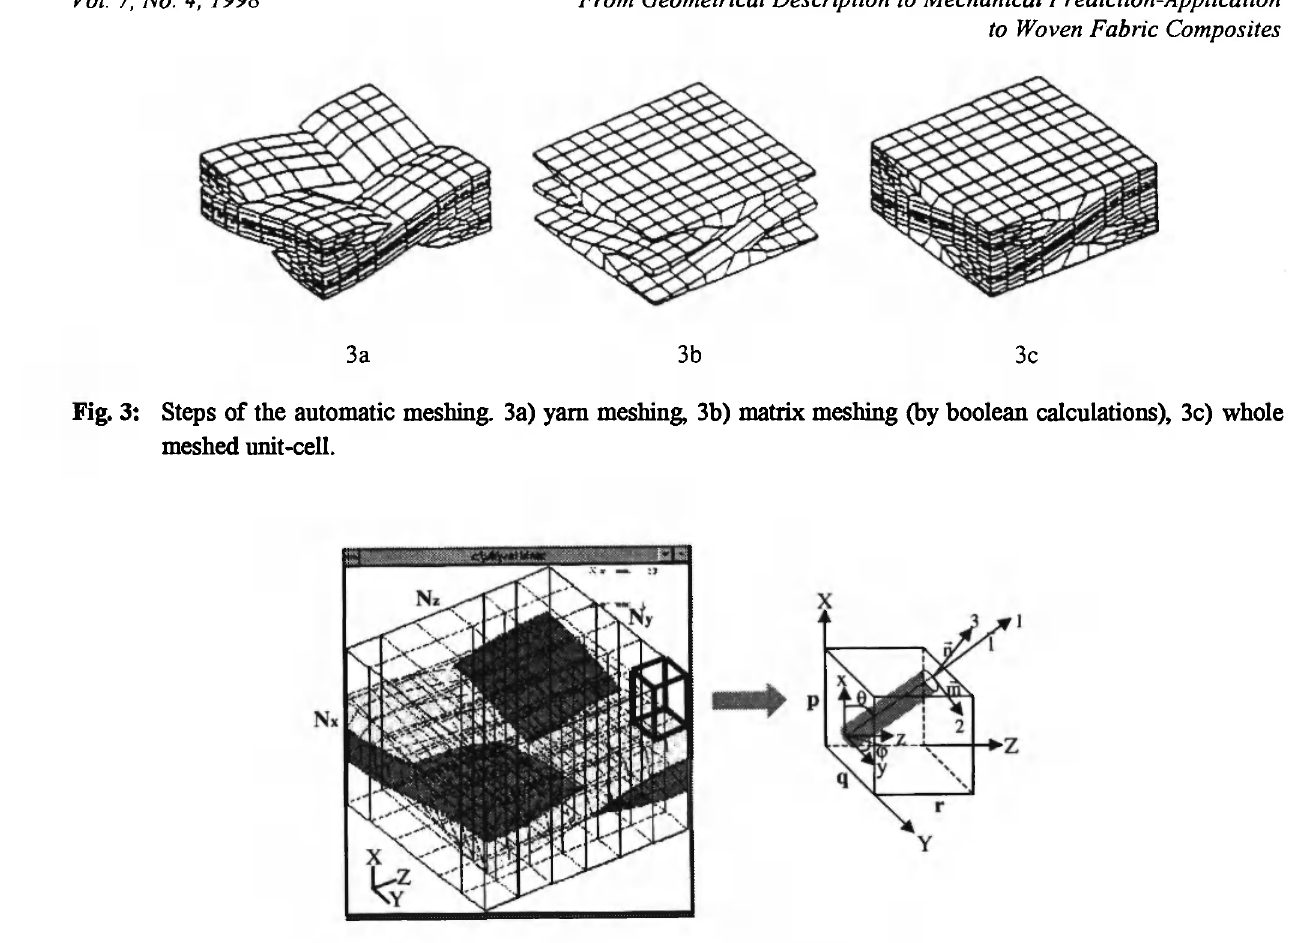
Fig. 4: The unit-cell is an aggregate of sub-cells.